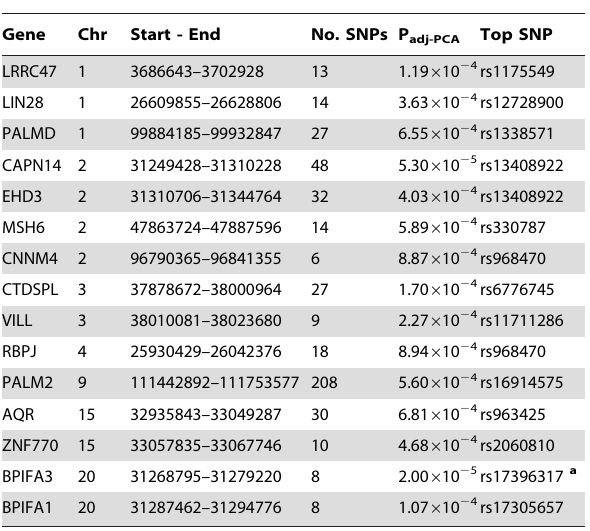
a - rs17396317 lies within the pseudogene BPIFA4 , 15.258 kb upstream of BPIFA3 . Ordered by chromosome and physical location.